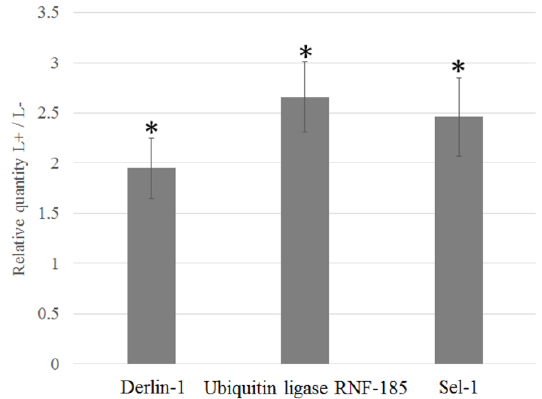
Figure 4. Relative quantification of the ERAD genes Derlin-1, Ubiquitin ligase RNF-185, and Sel-1. The expression is normalized to the elongation factor 1 gene in CLso-infected midguts of B. trigonica by qPCR relative to uninfected midguts. Asterisks above columns indicate statistically significant di ff erence when compared to the uninfected control.